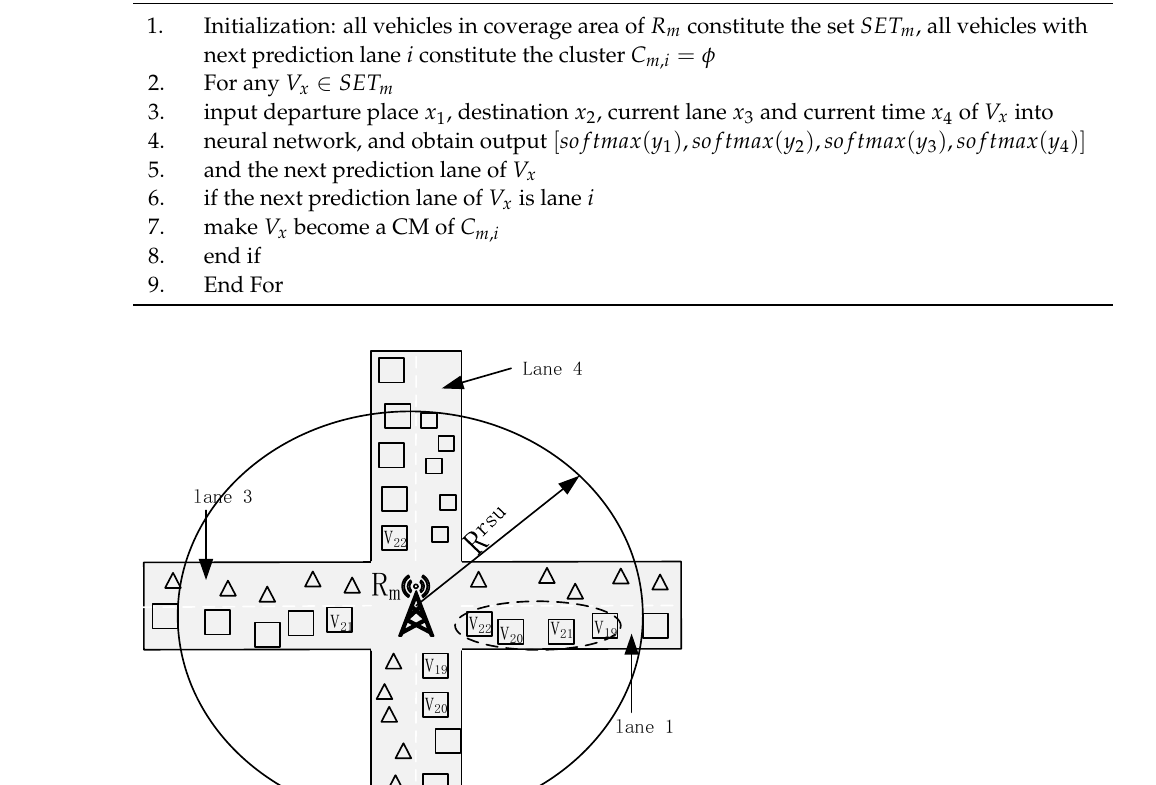
Algorithm 1 Cluster Dividing Algorithm Based on Mobility Prediction